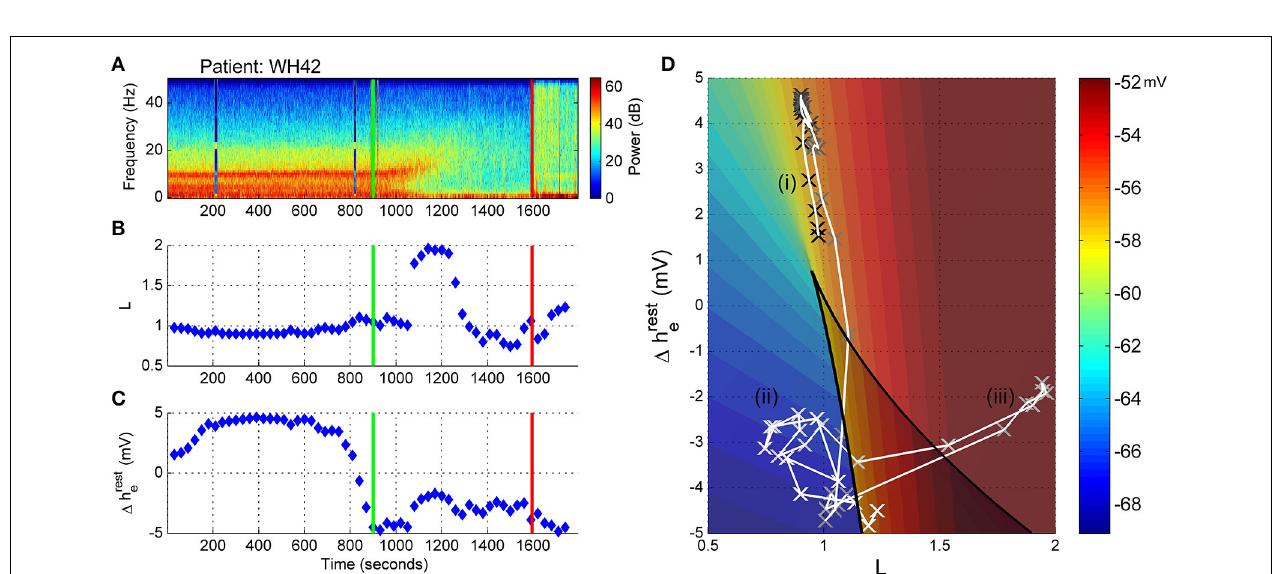
blue line, left vertical axis, and opioid levels as equivalent Fentanyl (C e Fentanyl, ng/ml), green line, right vertical axis. (D) Absolute alpha power (dB) against absolute delta power (dB) for prior to start of emergence (black circles), during emergence period (blue circles), and following recovery of response (ROR).